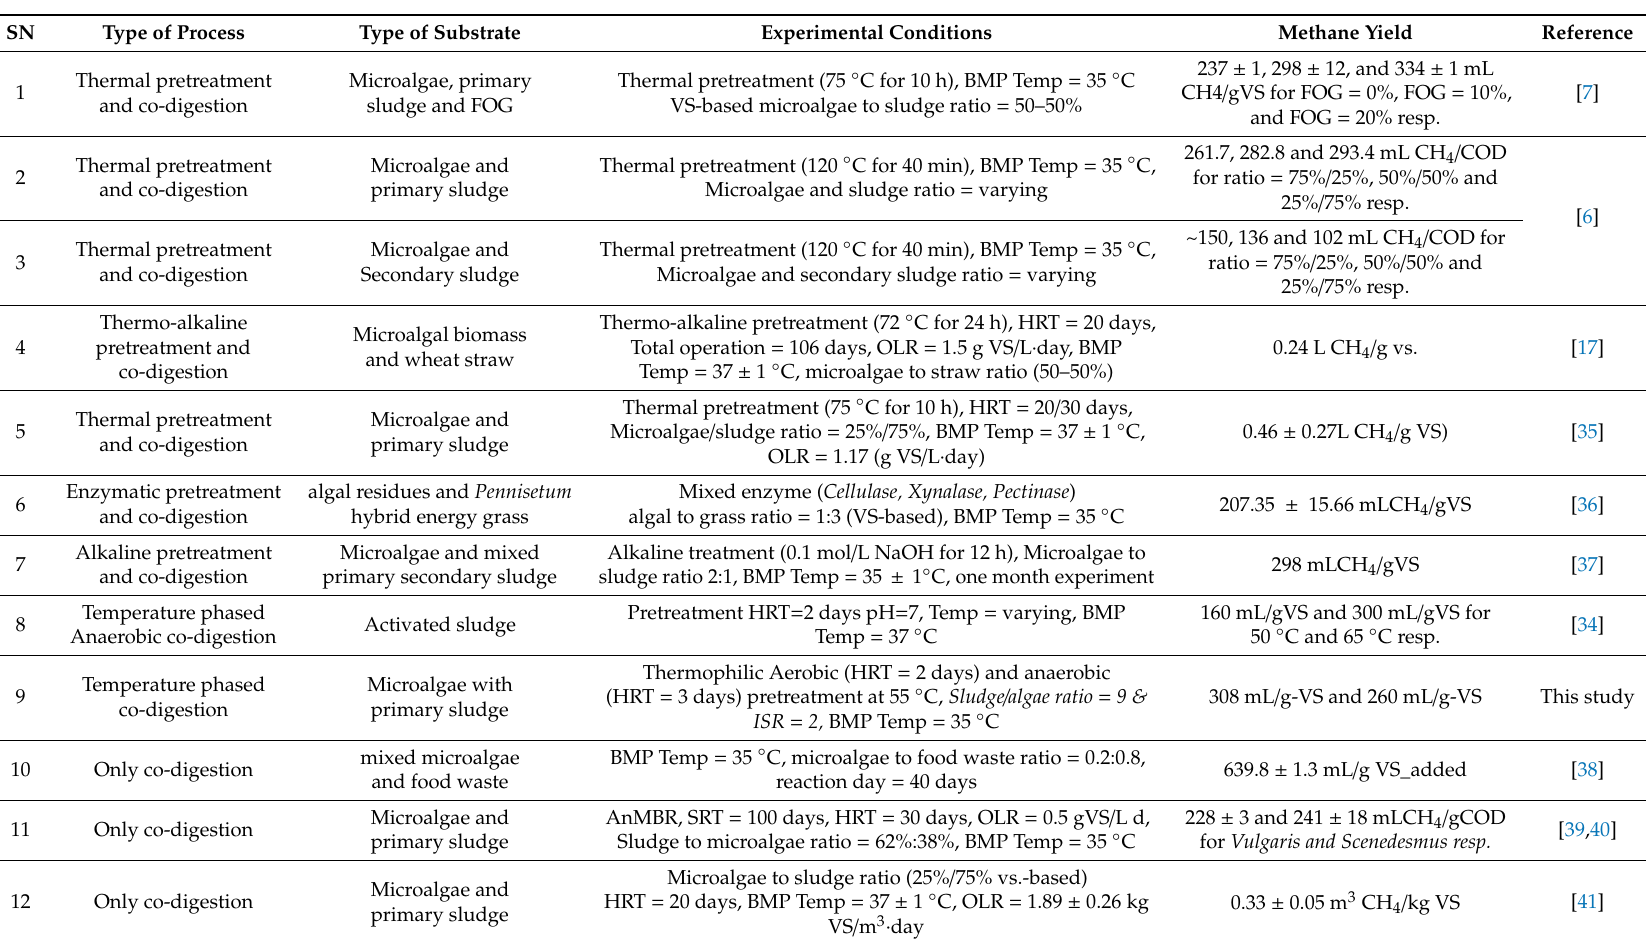
Table 6. Comparison between biomethanization tendency of this study and some other previous